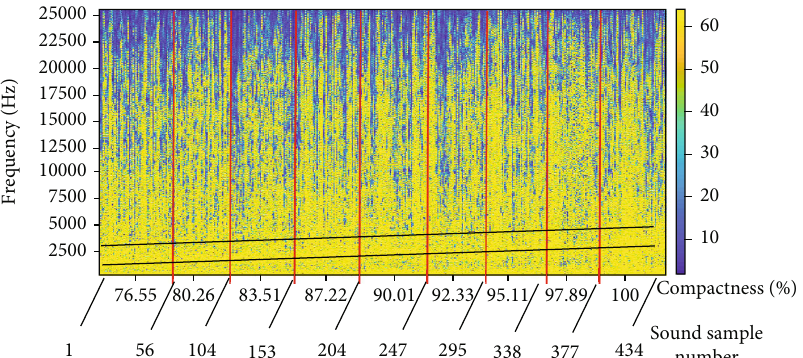
Figure 4: Full-band spectrograms of sound samples of di ff erent compaction of soil samples (yellow represents the peak frequency